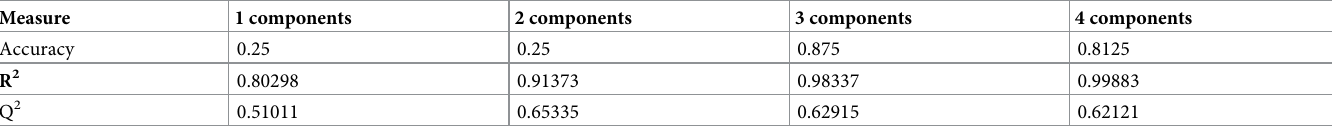
Table 2. PLS-DA cross-validation results based on R 2 parameters.